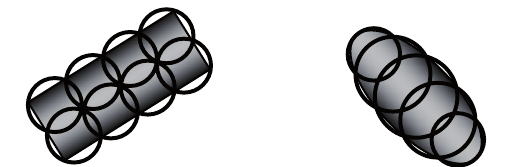
Fig. 4. A refined approximation with more circum-circles.